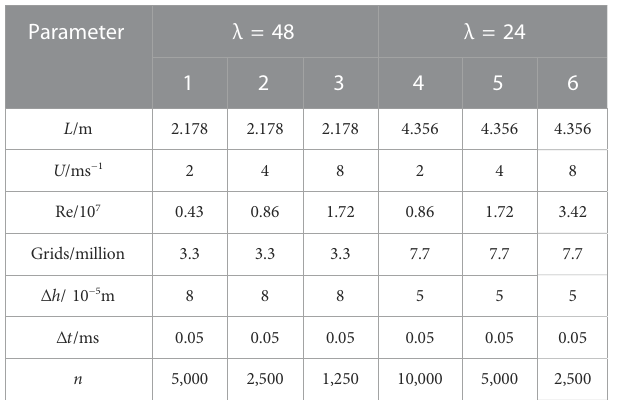
TABLE 2 Calculational parameters of the SUBOFF.